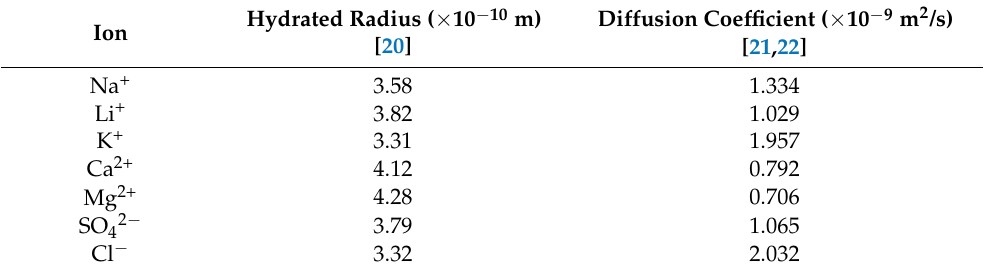
Table 1. Hydrated radius and diffusion coefficients of co-existing ions in feed